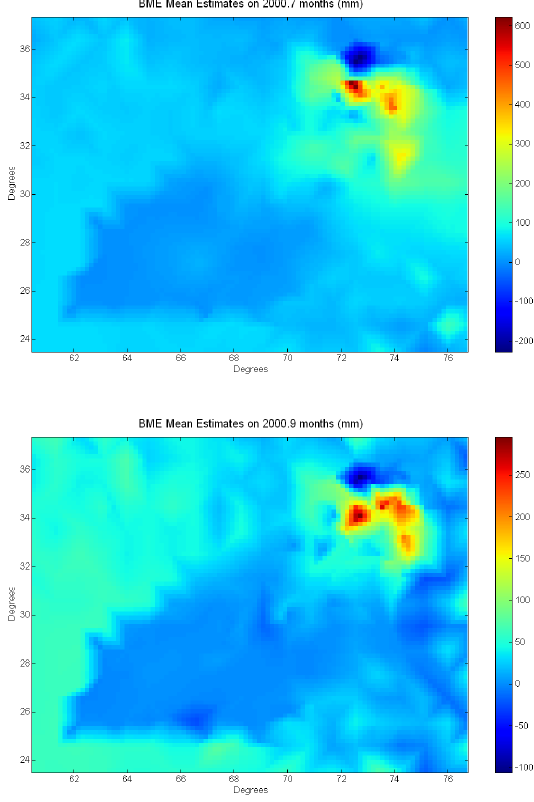
Fig. 5. The maps of average predicted rainfall BME spatio temporal method for the month of July and September of year 2000.